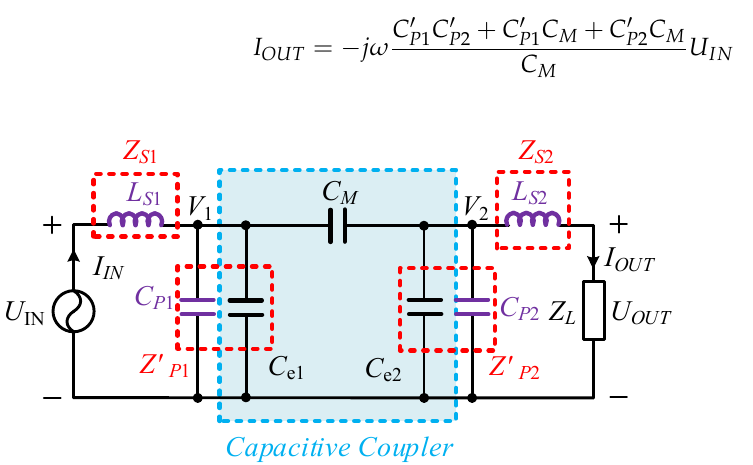
Figure 7. Double-sided LC compensation topology with π -type coupler model.